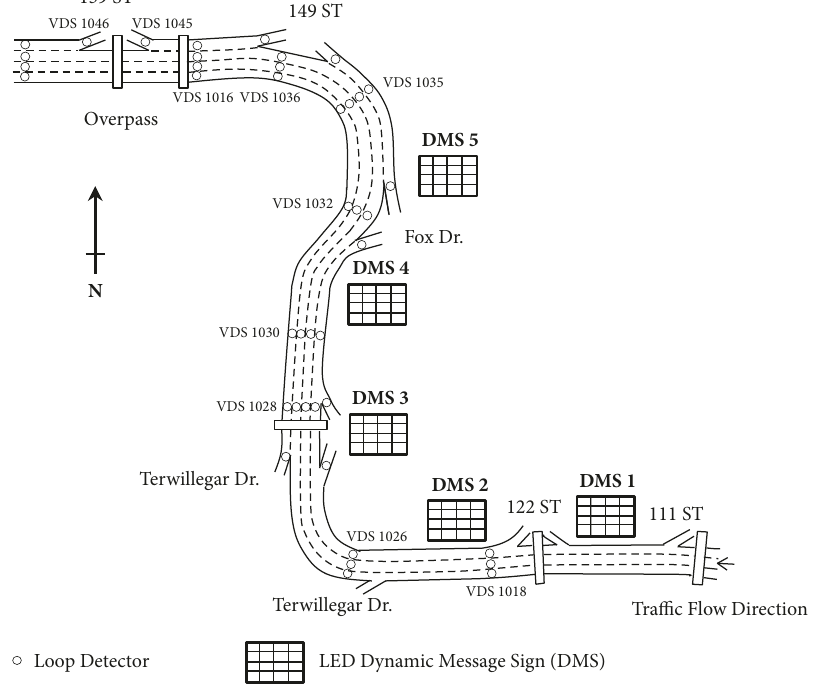
Figure 4: Vehicle detection stations and dynamic message signs on Whitemud Drive, Edmonton, Canada.